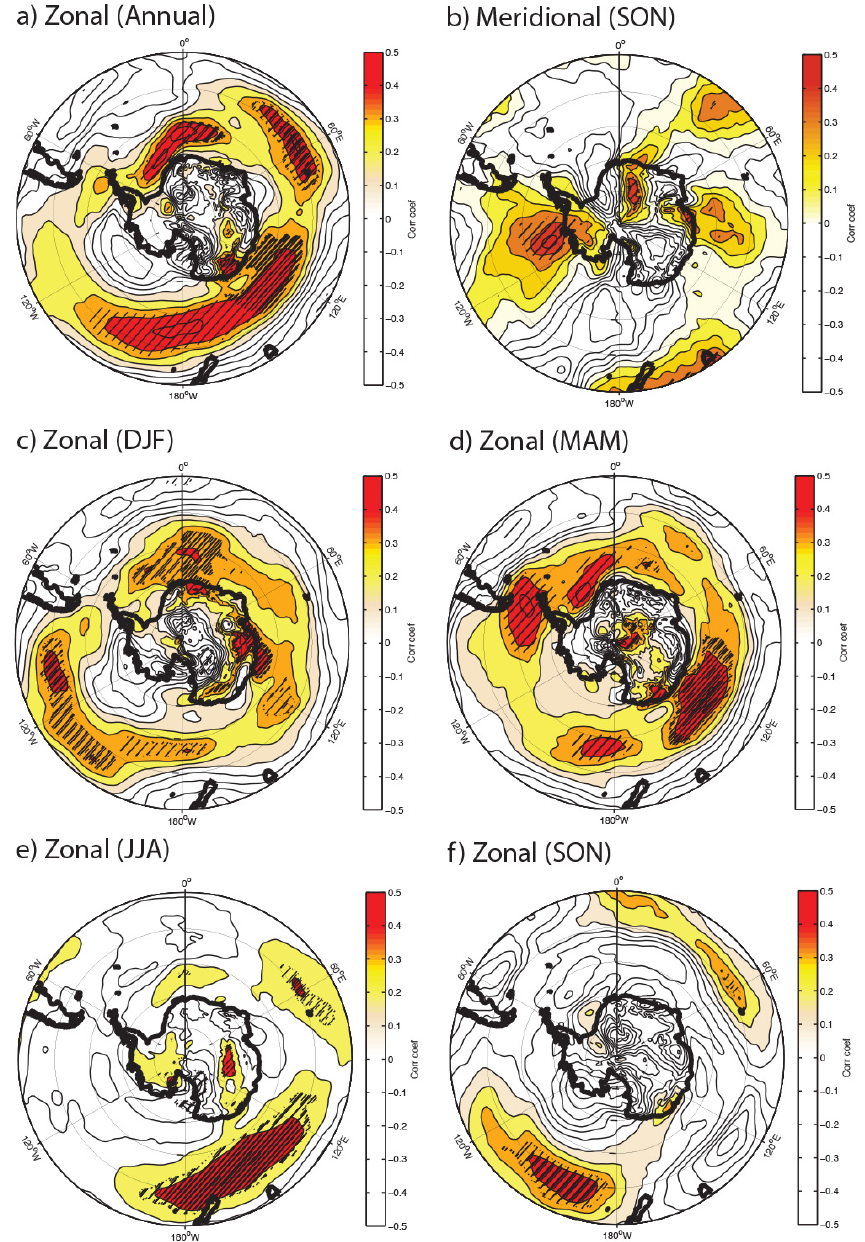
Figure 6. Spatial correlation maps showing Pearson’s linear correlation coefficient (colors) and regions of 90% significance (hatching) for correlation between WAIS Divide coarse particle percentage (CPP) and 700 hPa wind speed, 1979–2002: (a) annual mean zonal wind, (b) spring (SON) meridional wind, (c) summer (DJF) zonal wind, (d) fall (MAM) zonal wind, (e) winter (JJA) zonal wind, and (f) spring (SON) zonal wind. For clarity, we have colored only regions of positive